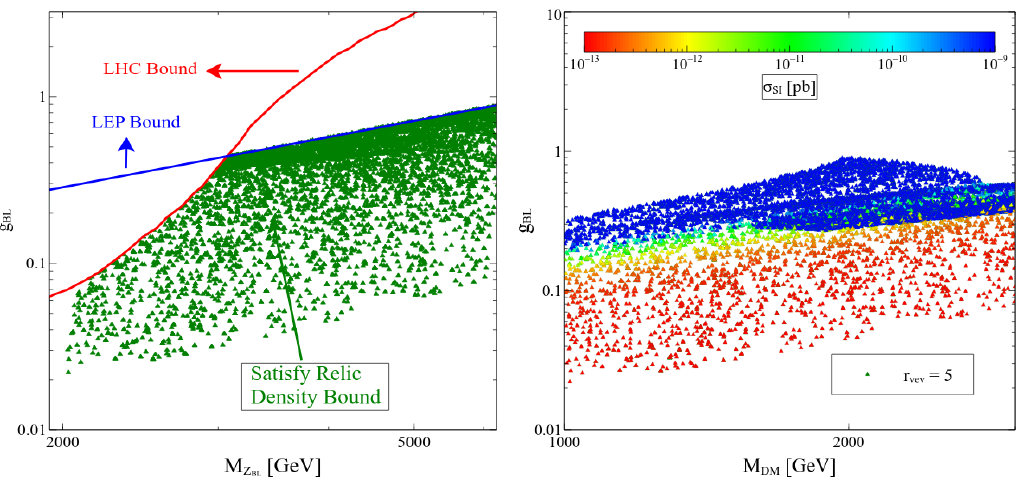
Figure 11 . Left (right) panel: scatter plot in the M Z the DM relic density bound. The parameters range have been shown in the table 2 and other parameters have been kept (cid:12)xed at r vev = 5, M N M N = M N 0 = 111 : 0 GeV, M h 3 3 h (cid:28)e = 1 : 34, sin (cid:12) = 0 : 07, (cid:1) M = M 2